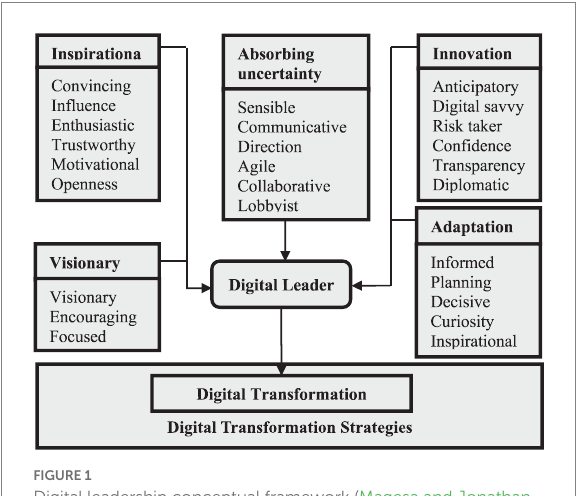
FIGURE 1 Digital leadership conceptual framework (Magesa and Jonathan,